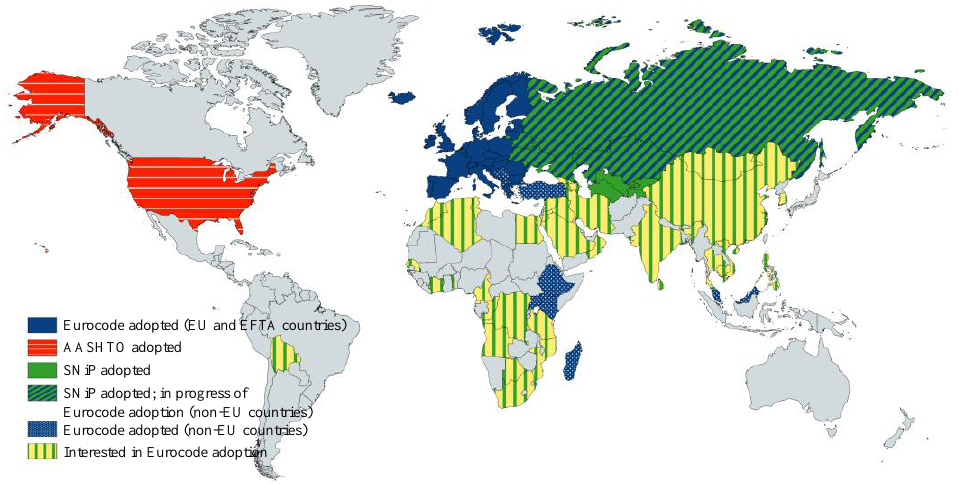
Figure 1. Distribution of building regulations around the world.